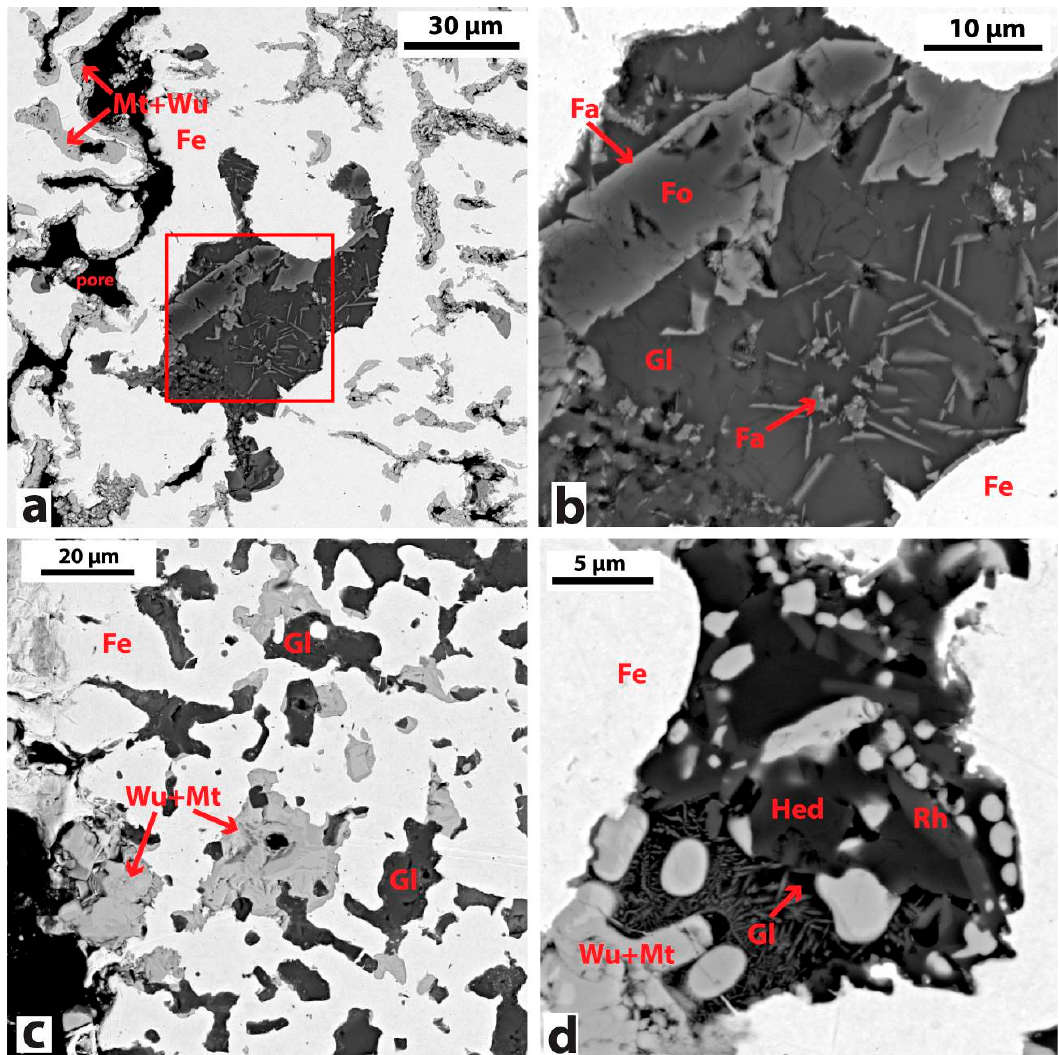
Figure 10. Typical microstructures of slag from M CB . SEM-BEI. Ajloun-3 ( a , b ): ( a ) Intermetallic grain area occupied by medium-sized (50 μ m) inclusion of silicate slag. Elongated inclusions of magnetite-wustite (Mt + Wu) ex-solutions occur at the boundaries of metal grains (Fe); ( b ) magnified area of a red rectangle from a . Primary prismatic crystals of forsterite (Fo, core) ― fayalite (Fa, exterior) series, in the glassy matrix incorporating secondary fayalite microlites. Negev-4 ( c,d ): ( c ) Highly heterogeneous area of the metal sample. Contains inclusion of microlitic glass and inclusions composed of wustite-magnetite ex-solutions; ( d ) Small slag area composed of ahnedral crystals of hedenbergite (Hed), small prismatic crystals of rhonite (Rh), and microlitic glassy matrix. Wustite-magnetite ex-solutions are present at the metal-slag periphery and within silicate slag.